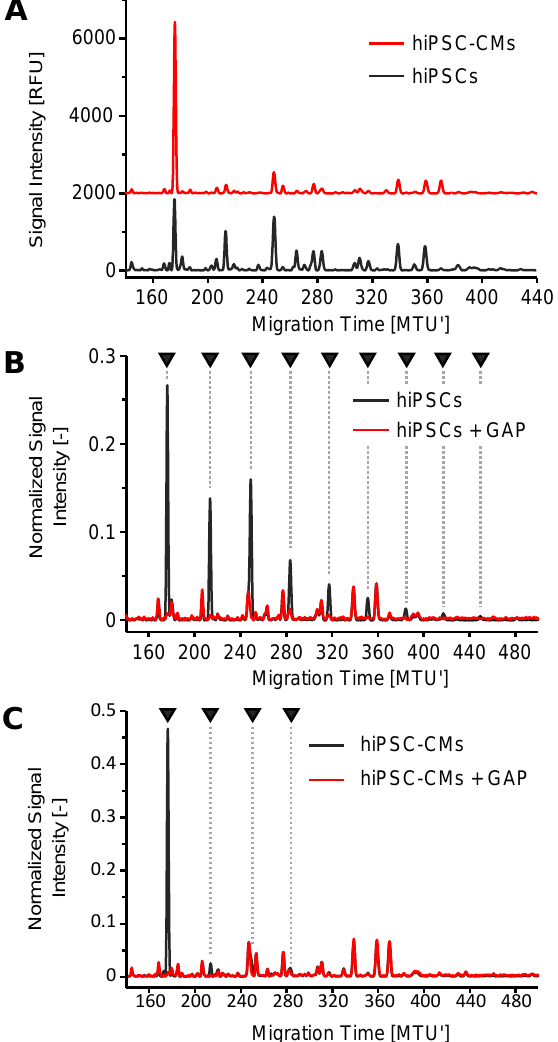
Figure 5. N -glycans of human-induced pluripotent stem cells (hiPSCs) and stem cell-derived car- diomyocytes (hiPSC-CMs) ( A ) were analyzed by xCGE-LIF without prior purification on the glyco- protein level. Interfering OSIs suspected by migration time matching to be maltodextrins in hiPSCs ( B ) and hiPSC-CMs ( C ) were confirmed and degraded by enzymatic treatment with glucoamylase P (GAP). The enzymatic degradation of interfering OSIs clarifies the differences in N -glycan fin- gerprints during cell differentiation. Peaks containing OSIs are marked with a black arrow. Signal intensity (normalized with sum of picked peak heights = 1 in Panels B and C ) was plotted over aligned migration time in Migration Time Units (MTU (cid:48) ). For comparison of the normalized signal intensities of N -glycan-derived peaks, peaks of OSI degradation products were considered for signal normalization, too. Data analysis was performed using